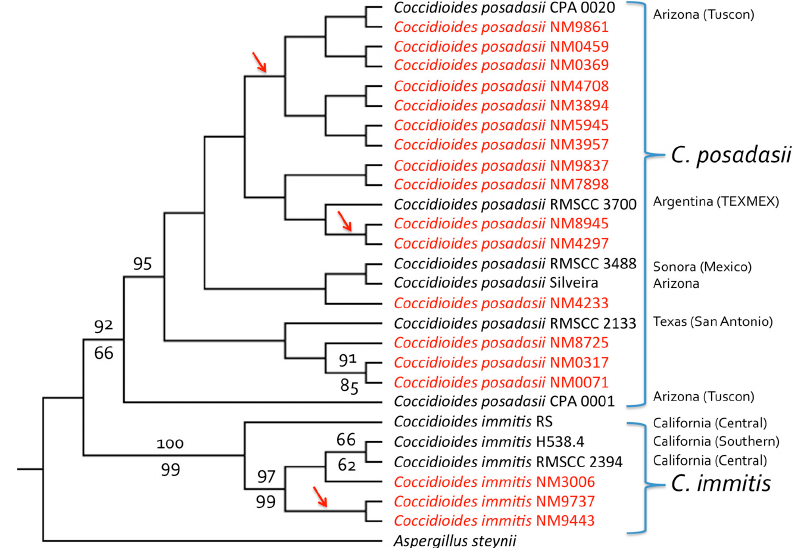
Figure 1. Four-gene phylogeny (DNAMLK) for clinical Coccidioides isolates from New Mexico and the Four Corners region. The tree was derived from a concatenated alignment of partial sequences from four gene regions: Serine protease, MCM7, RPB1, and ITS; trees for individual genes are shown in Figure S1 (with all four genes agreeing in terms of species separation). Both C. posadasii and C. immitis isolates were present among those obtained from patients in New Mexico (shown in red). As expected, based on previous analyses of isolates from California, Arizona and Texas, most NM isolates were from C. posadasii ( C. immitis being known primarily from CA). One patient infected with C. immitis (isolates NM9443 and NM9737) was a resident of the Four Corners region of Utah, while another (isolate NM3006) was from the Four Corners region of NM with no apparent travel history to California. GenBank accession numbers are given in Table 3. Bootstrap values (percentage of 1000 replicates) greater than 60% are shown for maximum likelihood analysis above the branches and for parsimony analysis below the branches. The tree was rooted with Aspergillus steynii . Maximum likelihood and parsimony analyses performed without sequences from A. steynii , and employing midpoint rooting, separated C. immitis and C. posadasii clades with 100% bootstrap support and placed the root between the two species (results not shown). Arrows indicate branches leading to isolates with identical